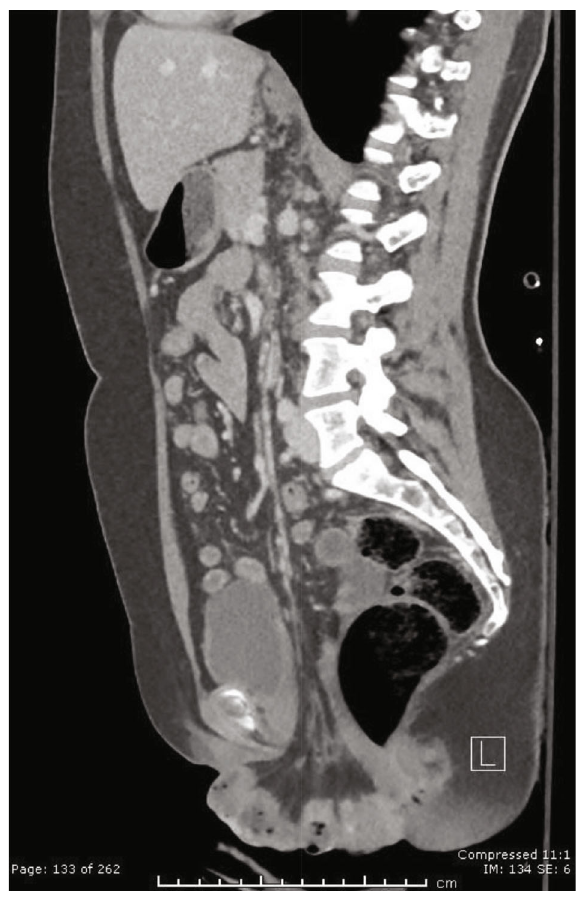
Figure 2: Axial CT image with intravenous contrast: image demonstrates pelvic fl oor dysfunction with rectovaginal space